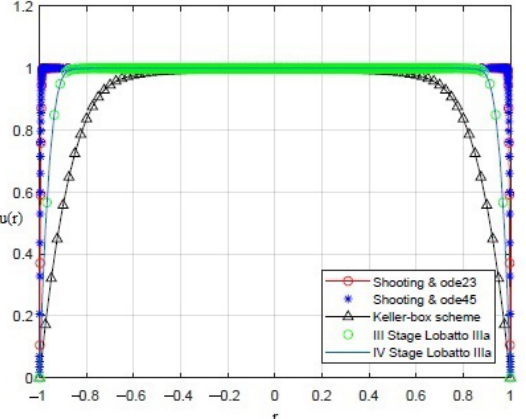
Figure 6. Recovering of u ( r ) for δ = 1.5 and θλ 2 as reported in Tables 1 and 2.